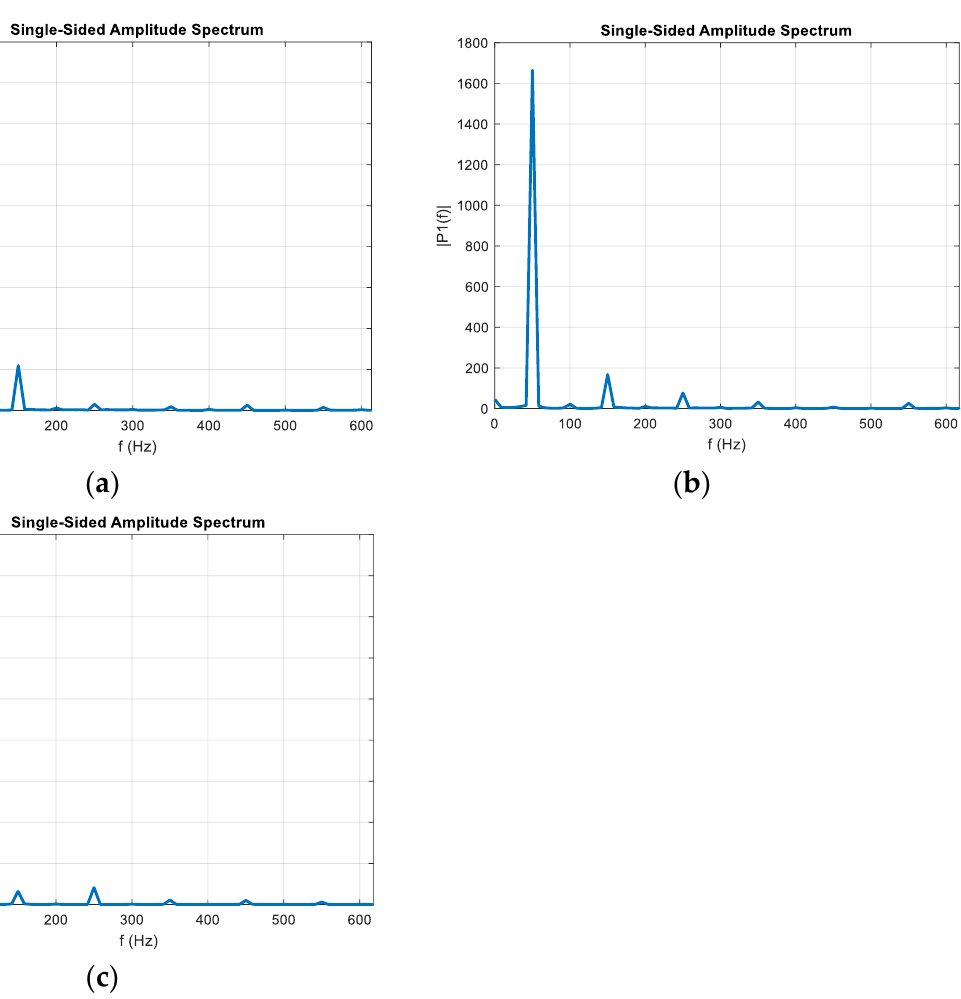
Table 3. The average value of the harmonic distortion coefficient of the currents of the network phases throughout the studied control interval for different methods of choke control.